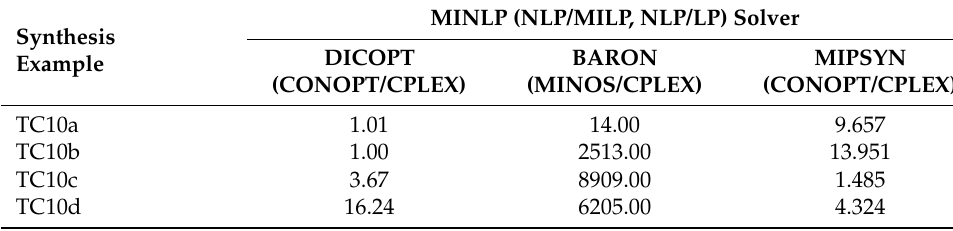
Table 11. The comparison of the CPU times (in